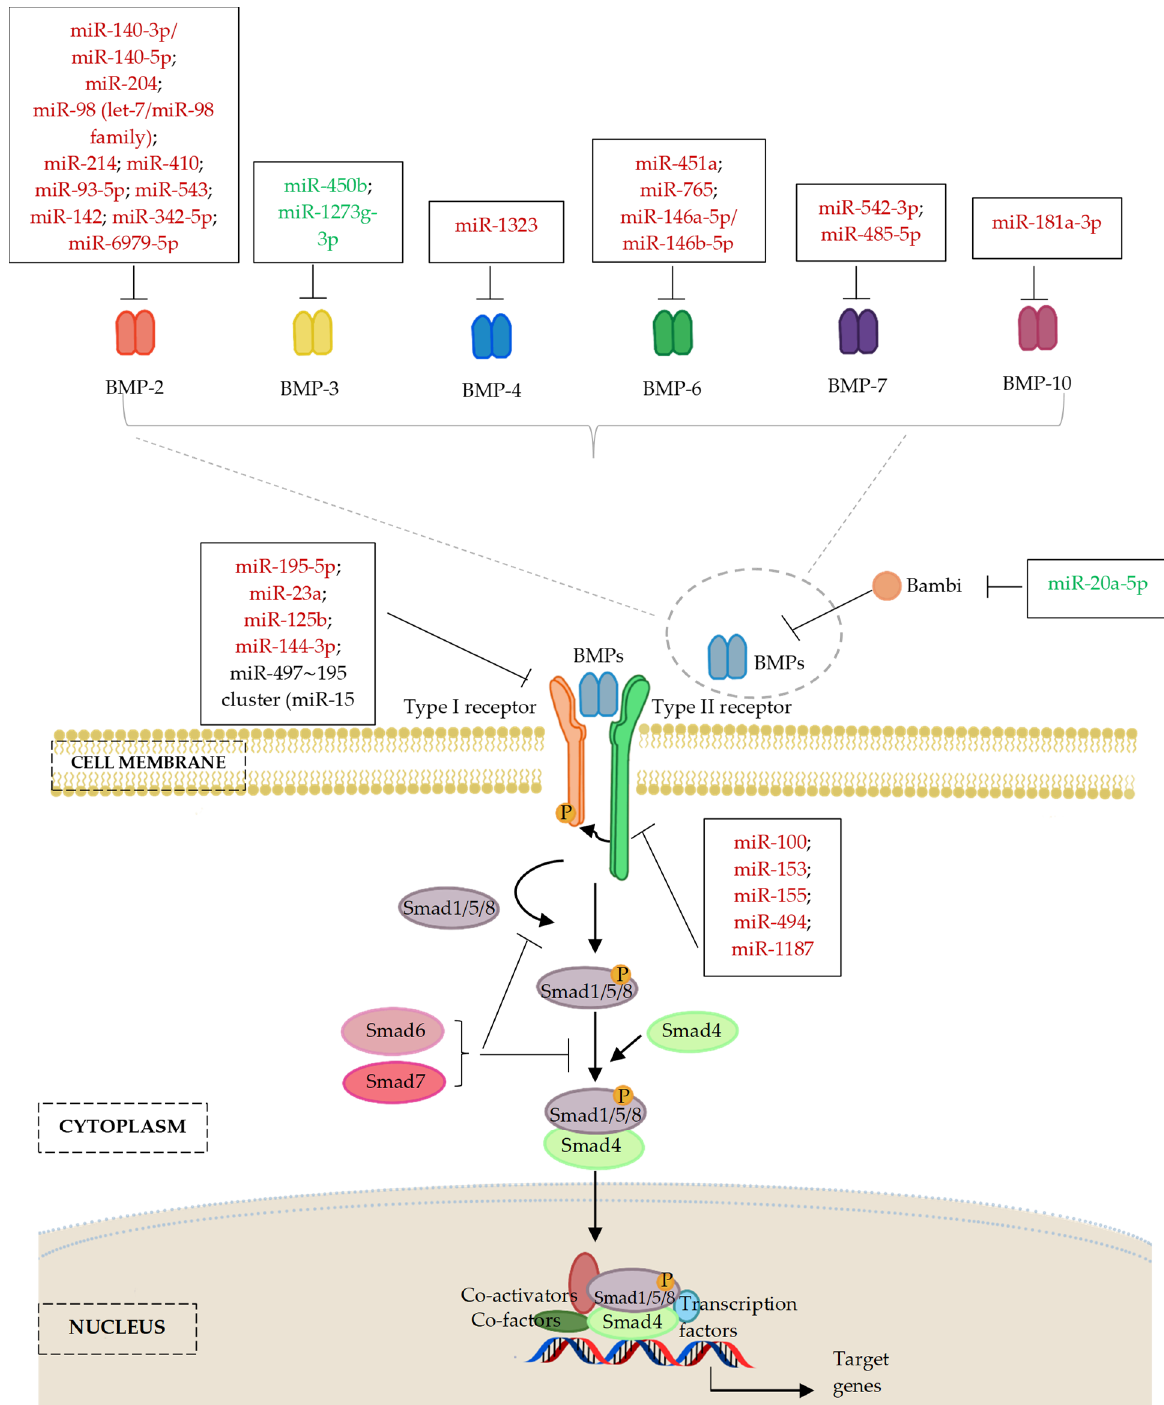
Figure 4. MicroRNAs with regulatory effects on components of bone morphogenic protein (BMP) signalling. Notes: MicroRNAs in green indicate positive regulation on osteogenesis, and microRNAs in red indicate negative regulation on osteogenesis, while microRNAs in black text indicate both positive and negative effects on osteogenesis.